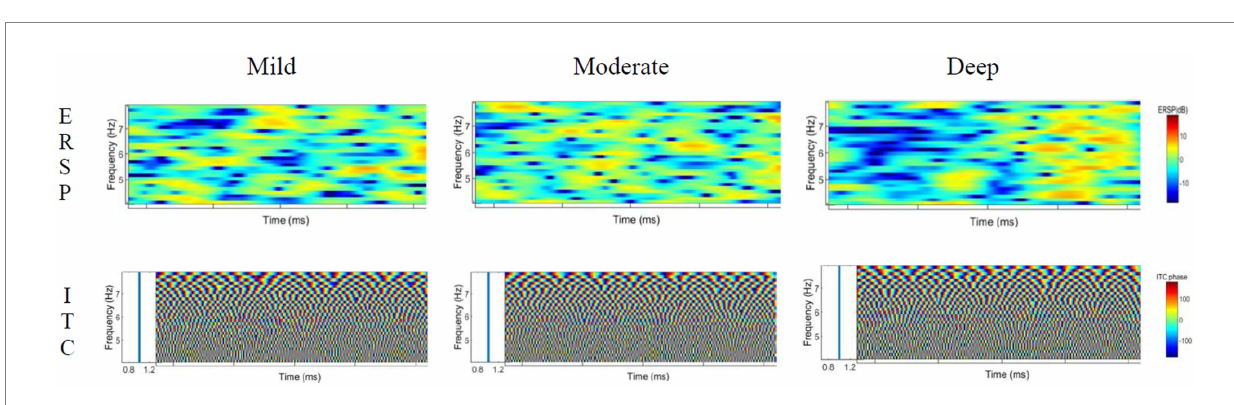
FIGURE 10 ERSP and ITC characteristics of theta wave under different cognitive workload